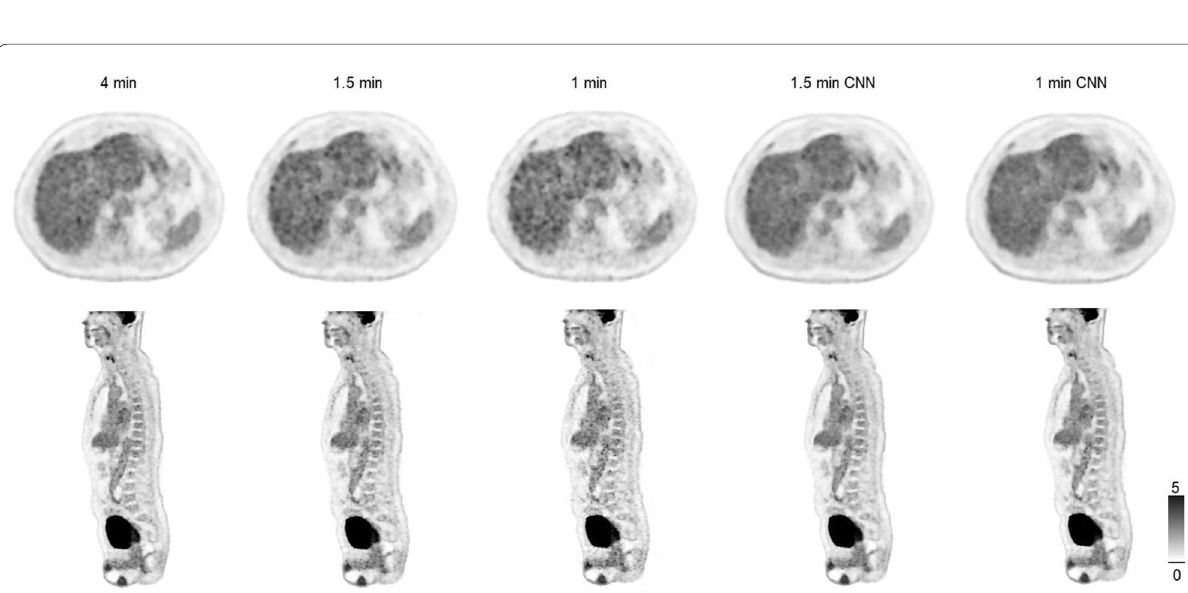
Fig. 7 Transaxial PET images of the upper abdomen and midline sagittal images of the image sets in the test group. Noise in the liver increases as scan time per bed position is decreased, both corresponding CNN series have markedly less noise in the